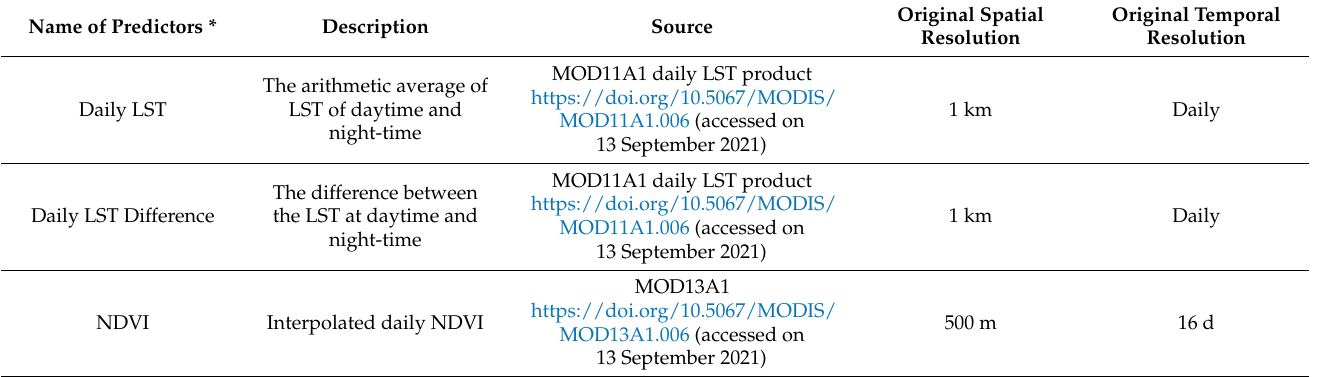
Table 1. Land Surface Features and Data Sources